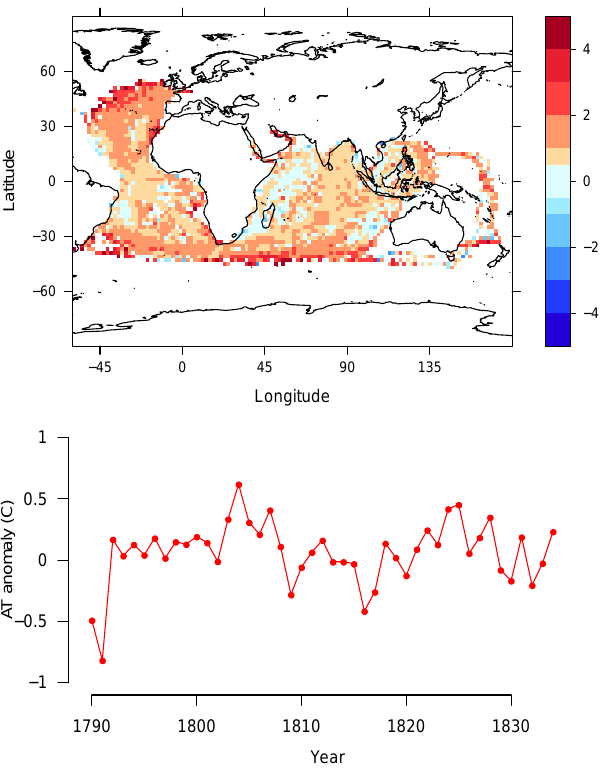
Fig. 6. Air pressure (AP) anomalies from mercury barometers Fig. 6. Air Pressure (AP) anomalies from mercury barometers (hPa): observations minus a sea-level pressure climatology for (hPa): observations minus a sea-level pressure climatology for 1961–1990 (Allan and Ansell, 2006). Upper panel: mean AP 1961–90 (Allan and Ansell, 2006). Upper panel: mean AP anomaly anomaly in each 2 × 2 degree square. Lower panel: mean AP in each 2x2 degree square. Lower panel: mean AP anomaly in each anomaly in each year.